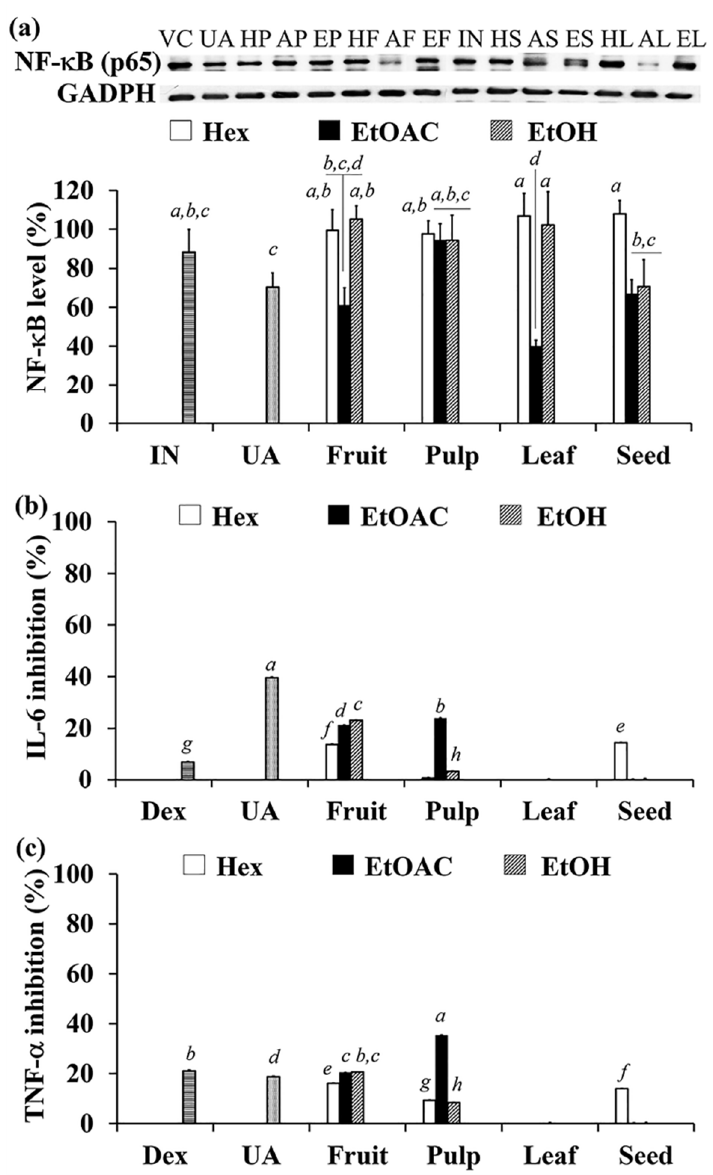
Figure 7. The effect of ursolic acid (UA), and C. carandas sequentially extracted using n -hexane (Hex), ethyl acetate (EtOAc), and 95% ethanol (EtOH), respectively, on NF- κ B protein expressions in U937 cells ( a ), IL-6 ( b ) and TNF- α ( c ) secretion in RAW 264.7 cells. Various C. carandas extracts included n -hexane extracts from fruit (HF), leaf (HL), seed (HS), and pulp (HP); ethyl acetate extracts from fruit (AF), leaf (AL), seed (AS) , and pulp (AP); ethanolic extracts from fruit (EF), leaf (EL), seed (ES) , and pulp (EP) . Dimethyl sulfoxide was used as vehicle control (VC). Indomethacin (IN) and dexamethasone (Dex) were used as reference standard. The letters a , b , c , d , e, f , g , and h denote significant difference among different C. carandas extracts ( p < 0.05) after being analyzed by one-way ANOVA followed by Tukey’s test.